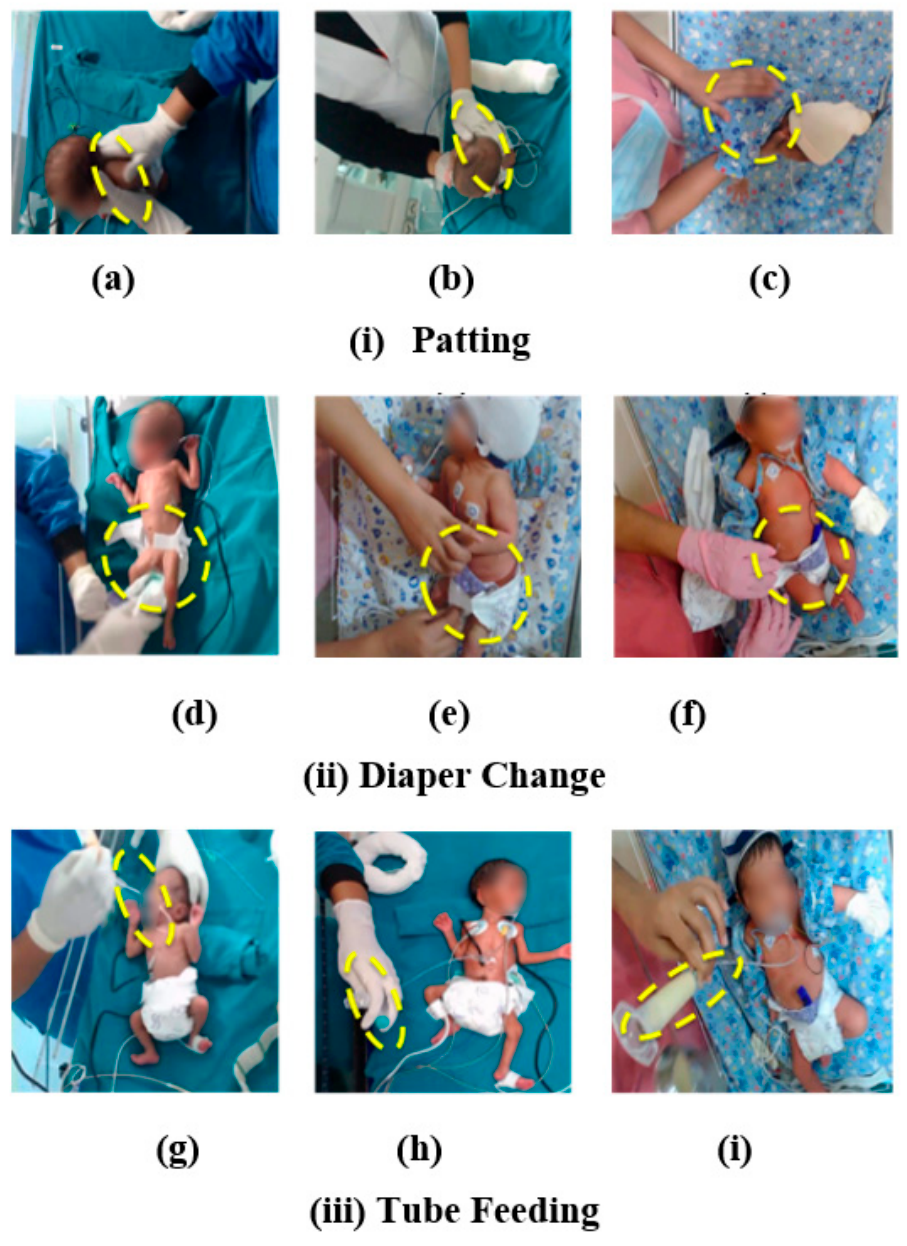
Figure 3. Images of manipulation: ( i ) patting, ( ii ) diaper change, and ( iii ) tube feeding, the region of interest marked with a yellow border.